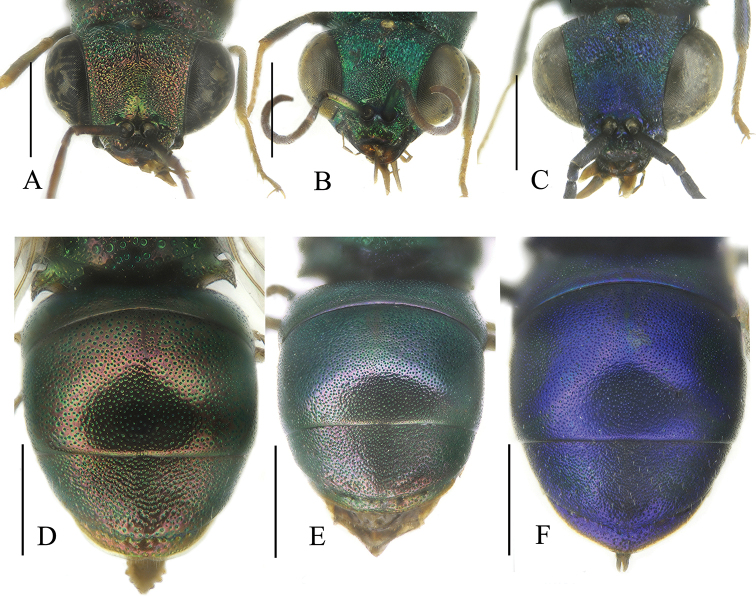
Spinolia species, females, head in frontal view (A–C), and metasoma in dorsal view (D–F). AS.
spinosa sp. nov. BS.
chalcitesCS.
unicolor. DS.
spinosa sp. nov. ES.
chalcitesFS.
unicolor. Scale bars: 1.0 mm.